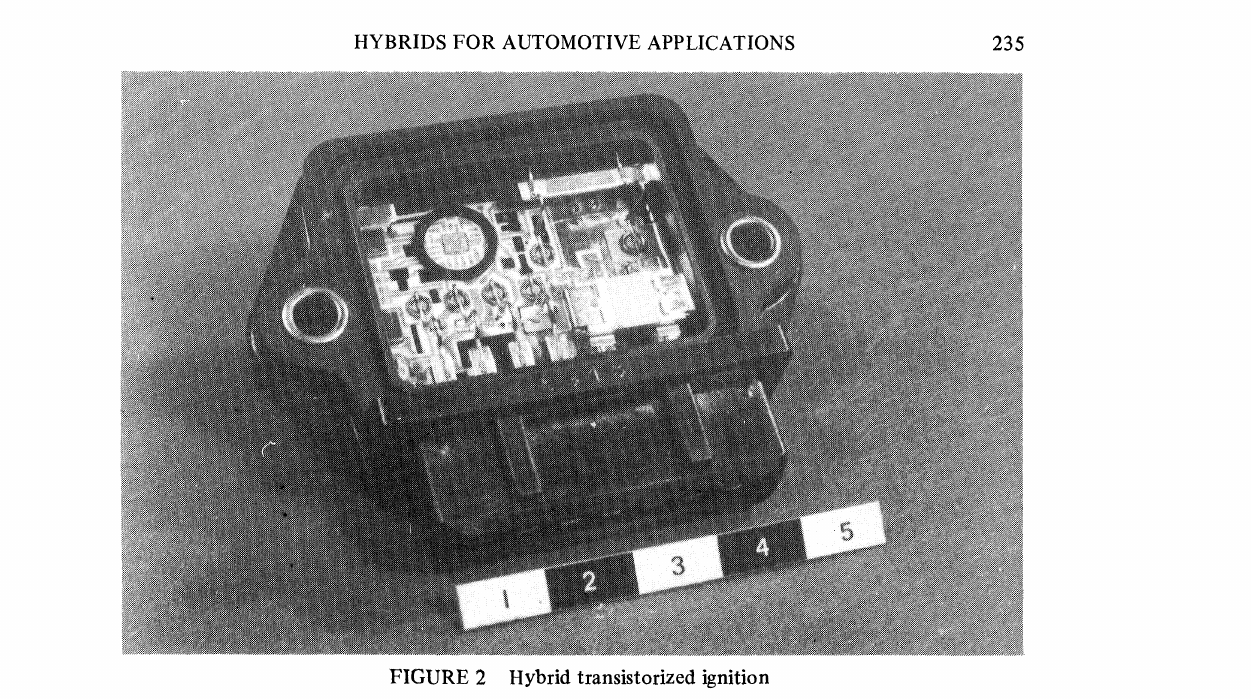
FIGURE 2 Hybrid transistorized